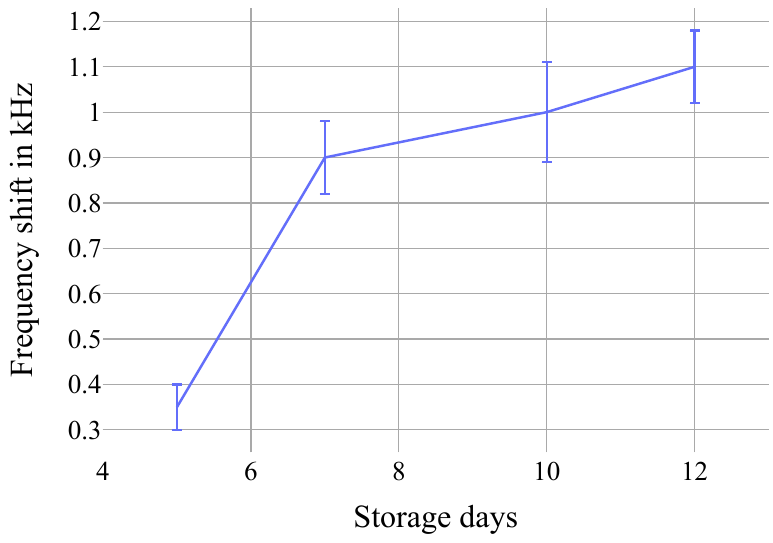
Figure 12. The shift in resonance frequency when exposed to tuna pieces with different ages, the error bars denote the shift in standard